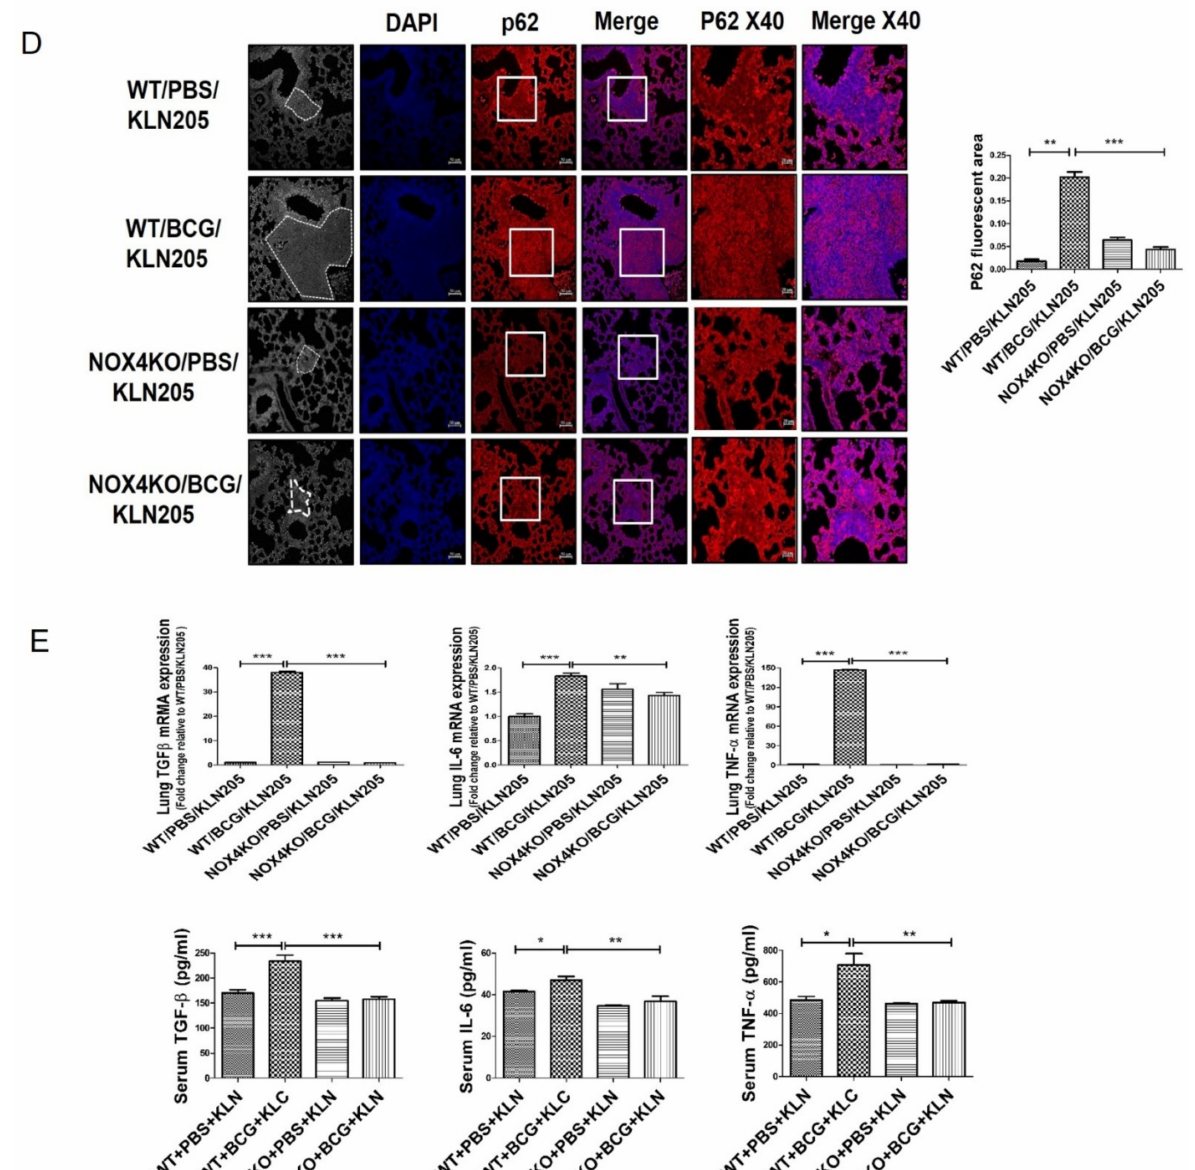
Figure 3. NOX4 mediates BCG pleurisy-promoted increased metastatic potential of lung cancer cells: ( A ) C57BL/6 NOX4 WT and KO mice were administered an intrapleural injection of BCG (1 × 10 6 CFUs BCG Pasteur in 100 µ L of saline). Each mouse also received an intravenous injection of KLN205 mouse lung cancer cells (2 × 10 5 ) at day 29. At day 43, lung tissues were harvested. Representative micrographs of Bouin staining of metastatic nodules are presented. ( B ) Histological images of lungs. H&E staining (50 × , 200 × ) and Ki67 immunohistochemistry (400 × ). Ki-67-positive cells show nuclear brown staining. ( C ) Lung cancer tissue lysates from each mouse were used for Western blotting of P62, ATG5-ATG12, LC3II/LC3I and Snail. ( D ) Activation of p62 deposition is regulated by NOX4 in a BCG pleurisy lung cancer model. p62 was subjected to immunofluorescence staining. Immunofluorescence staining of p62 (red); DAPI staining (blue); Purple represents colocalization of DAPI staining and immunofluorescence of p62. ( E ) RT-PCR analysis of TGF- β , IL-6, and TNF- α mRNA levels in mouse lung tissue lysates. ELISA analysis of TGF- β , IL-6, and TNF- α levels in mouse sera. Eight mice were used in each group ( n = 8 per group). *** p < 0.001, ** p < 0.01, * p <